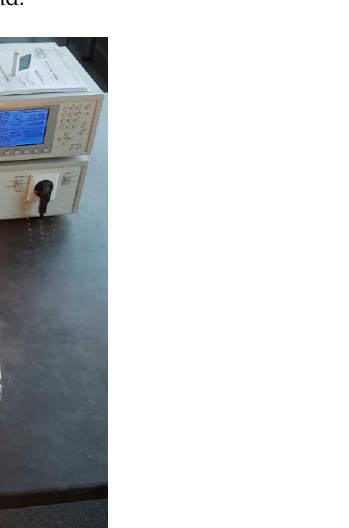
Figure 10. Scheme of the measuring stand.